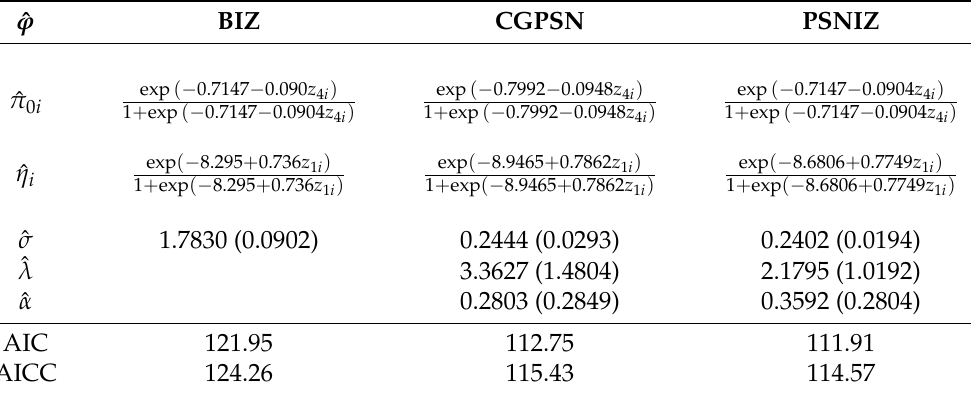
Table 2. Maximum likelihood estimates of the parameters for fitted